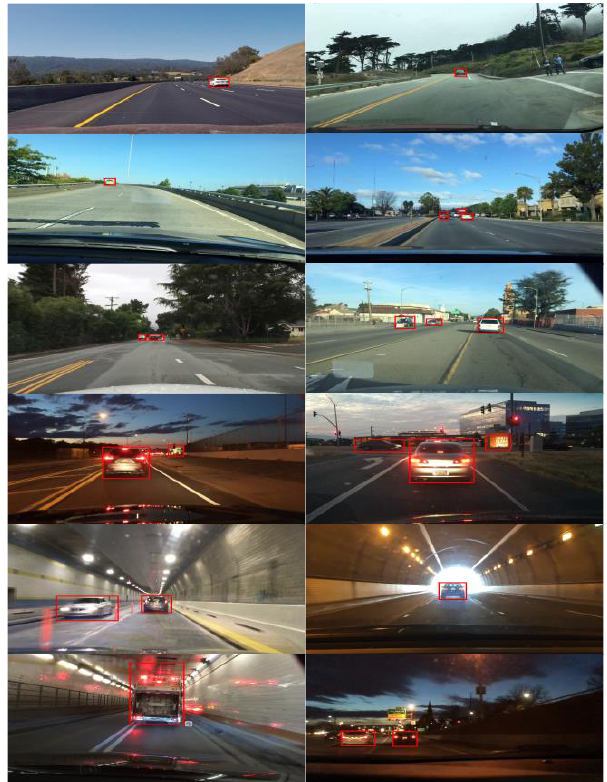
Figure 13. Detection results of good environments.